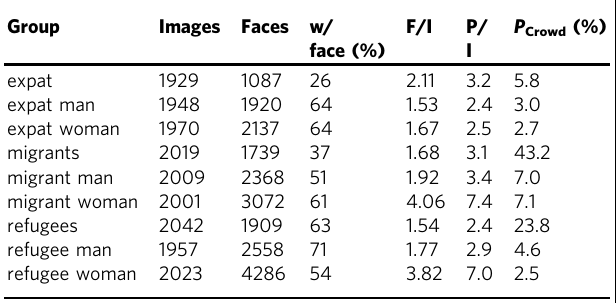
Table 1 The number of images used per group of interest and other relevant